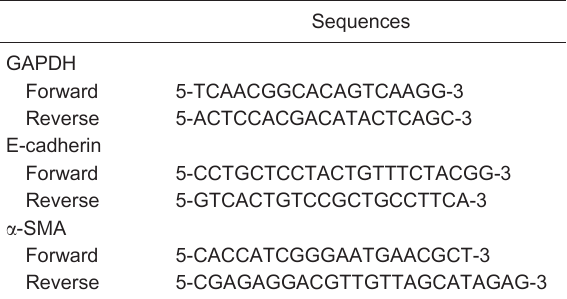
Figure 1. Systolic blood pressure (SBP) at baseline, 2 and 4 weeks. SN: Dahl salt-sensitive (SS) rats on a normal-salt diet (0.3% NaCl); SH: Dahl SS rats on a high-salt diet (8% NaCl); BN: SS-13 BN rats on a normal-salt diet (0.3% NaCl); BH: SS-13 BN rats on a high-salt diet (8% NaCl). + P , 0.05, ++ P , 0.01 compared with the SN group at the same time point; *P , 0.05 compared with the SH group at the same time point; # P , 0.05 compared with the SN group at the same time point (one-way